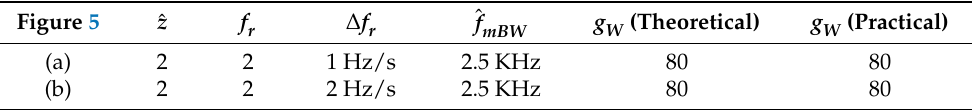
Table 2. Configuration of each parameter in Figure 5.